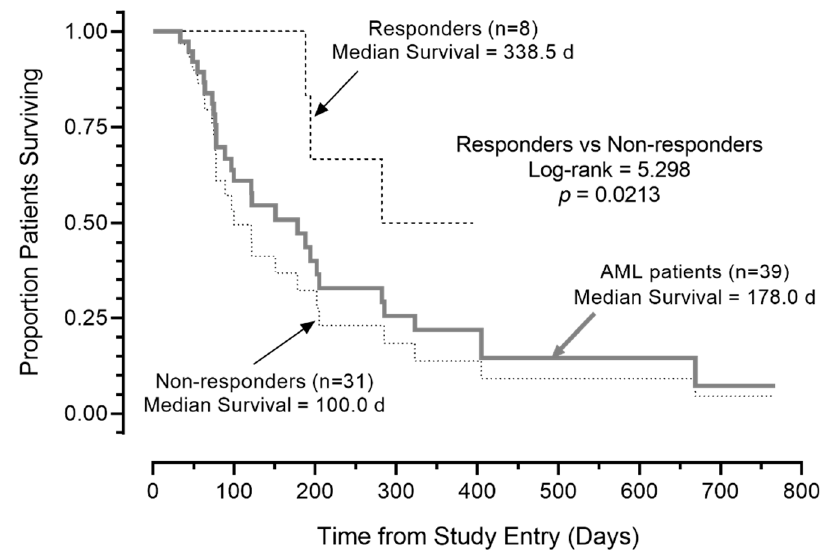
Figure 3. Survival outcome of AML patients according to response to APVO436. Depicted are the overall survival curves of the 8 patients’ favorable responses, 31 patients who did not respond, and all 39 patients combined. Favorable responses of CR, PR, or SD ≥ 3 months was associated with improved overall survival in R/R AML patients treated with APVO436 monotherapy.